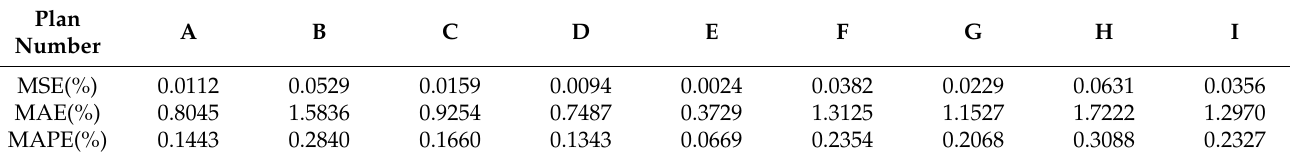
Table 12. The evaluation criterion of the orthogonal test.